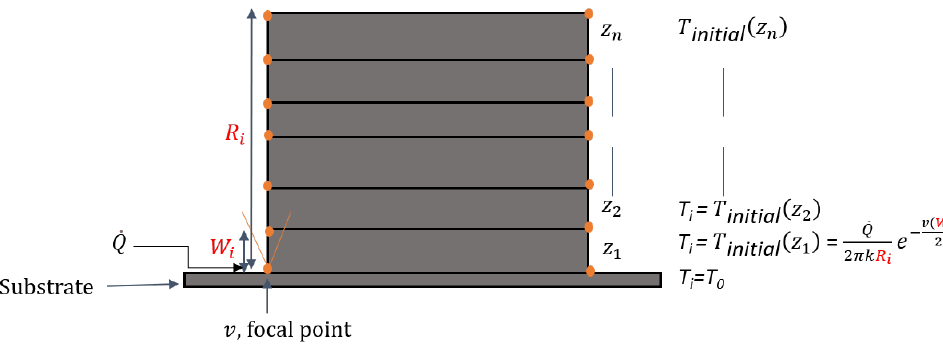
Figure 4. Rosenthal’s solution applied to the LWAM